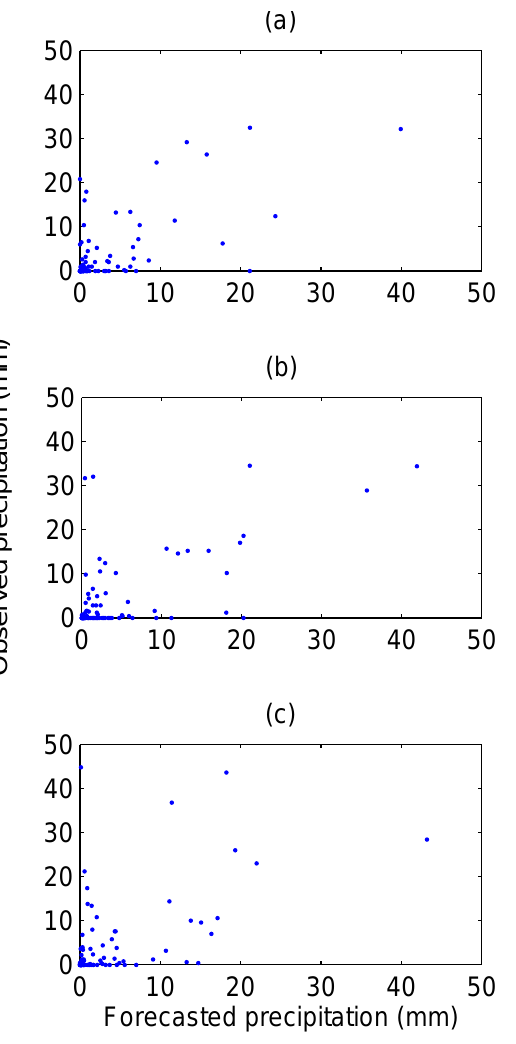
Fig. 2. Scatter plots of 48h ahead deterministic precipitation fore- casts and corresponding observations for (a) Station 7031360 (near outlet of the basin) (b) Station 7038885 (upper Baskatong, middle of the basin) and (c) Station 7038975 (Paugan).